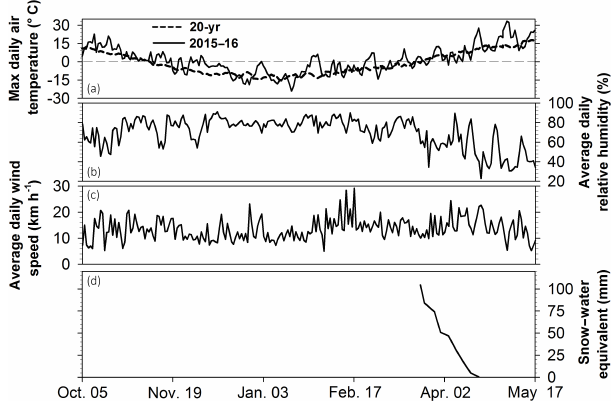
Figure 4. Daily records of (a) maximum air temperature (with 20- year average), (b) average daily relative humidity, and (c) average daily wind speed at Mildred Lake climate station from 5 Octo- ber 2015 to 17 May 2016, and (d) measured area-weighted SWE for Poplar Fen in 2016.